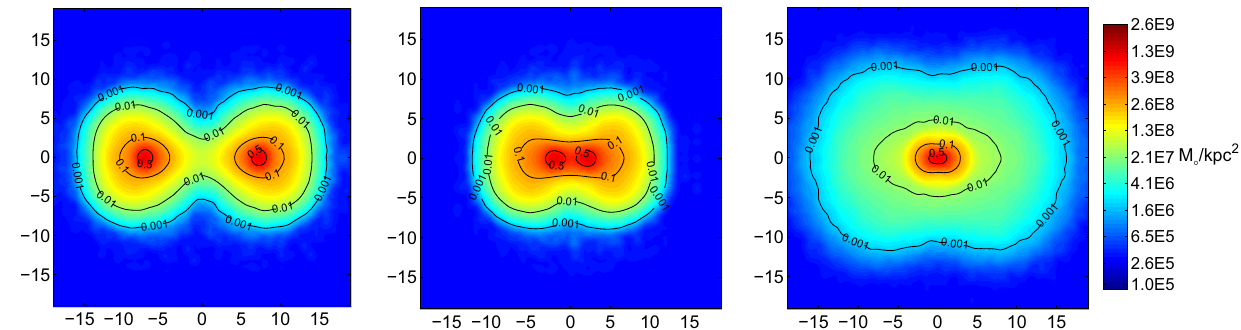
Fig. 2 Possible phenomenologies of the projected mass density pro- files for galaxy cluster collisions in CDM model, for different values of the kinetic parameter k . From left to right shown are the examples of a central symmetric fast collision ( k = 1 . 6, separation 15 r c ), a “free-fall” collision ( k = 1 . 0, maximum separation of approximately 6 r c ), and a slow collision ( k = 0 . 8, final merger configuration). The simulation parameters are as defined in Table 1. The projected mass density maps